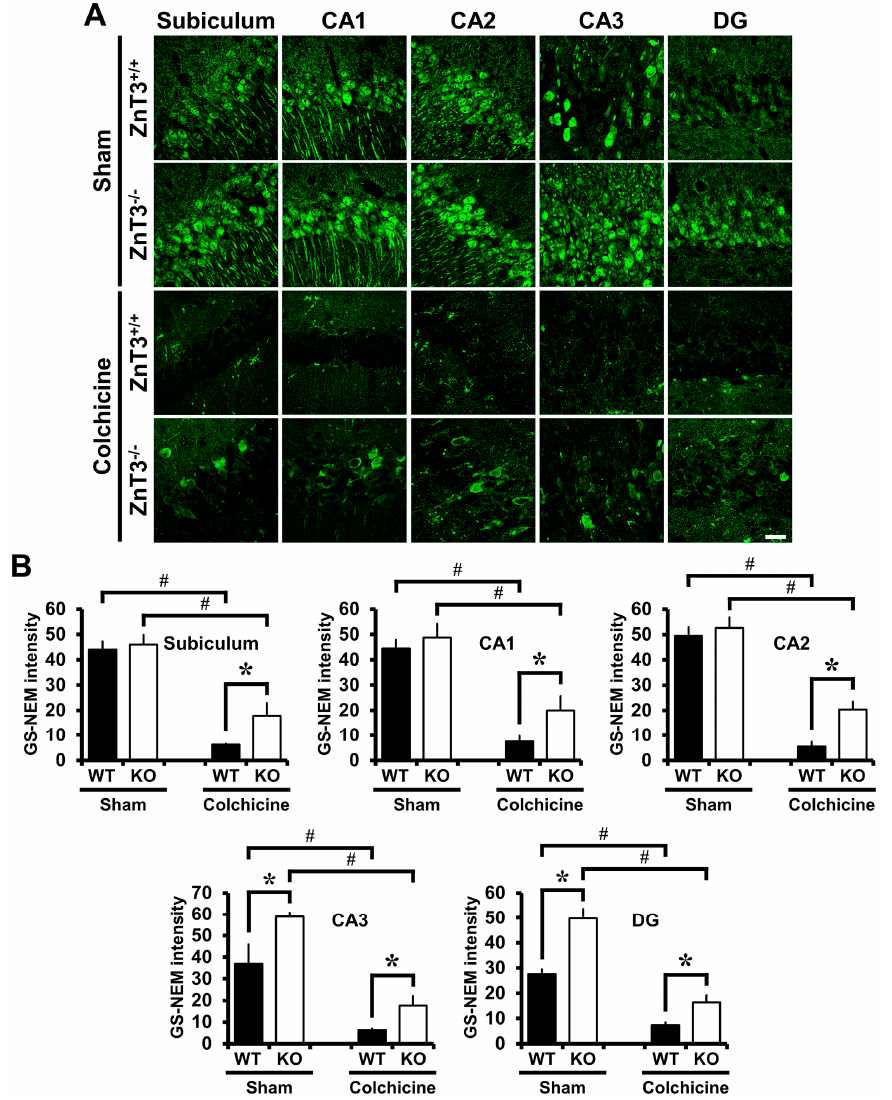
Figure 4. ZnT3 − / − mice have increased neuronal glutathione and reversed a reduction of neuronal glutathione (GSH) content after colchicine injection. Brain sections obtained from WT and ZnT3 − / − mice at 24 h after sham surgery or colchicine injection (WT-sham, n = 3; KO-sham, n = 3; WT-colchicine, n = 4; KO-colchicine, n = 5) were stained by GSH-N-ethylmaleimide (NEM) adduct (GS-NEM) antibody to detect the reduced form of GSH in the neurons. Representative immunofluorescence images ( A ) and quantification ( B ) for the degree of neuronal GSH levels are shown as the intensity of GS-NEM in the individual neurons of hippocampal regions including subiculum, CA1, CA2, CA3 and DG. Scale bar = 20 µm. Data are the mean ± SEM, * p < 0.05 versus WT mice, # p < 0.05 versus sham-operated mice.